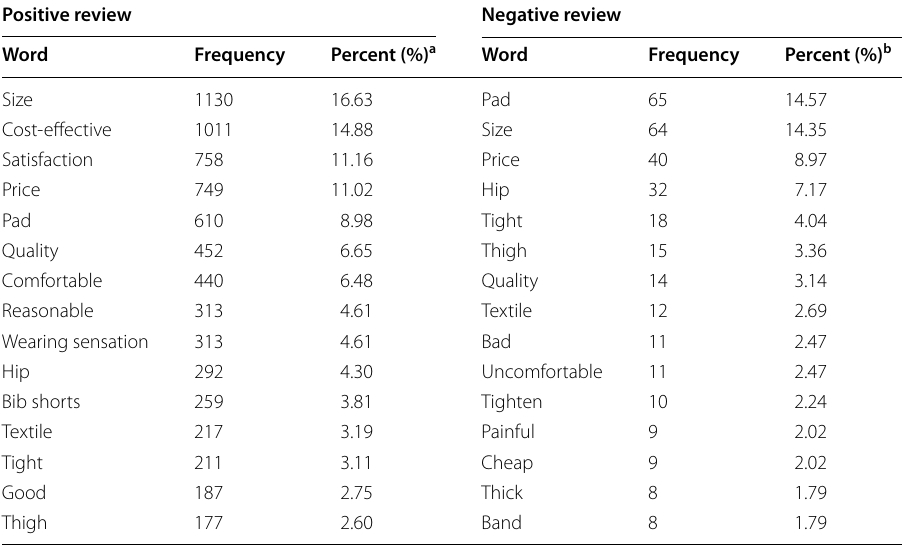
Table 3 Word frequency of reviews on cycling pants from 2017 to